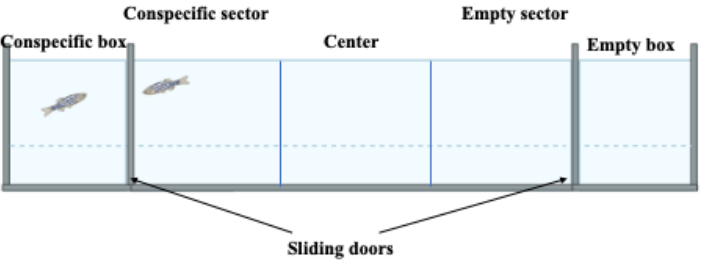
Figure 9. Social preference test apparatus in zebrafish. This test is ideal for investigating social behaviour in zebrafish. Created with Biorender.com.